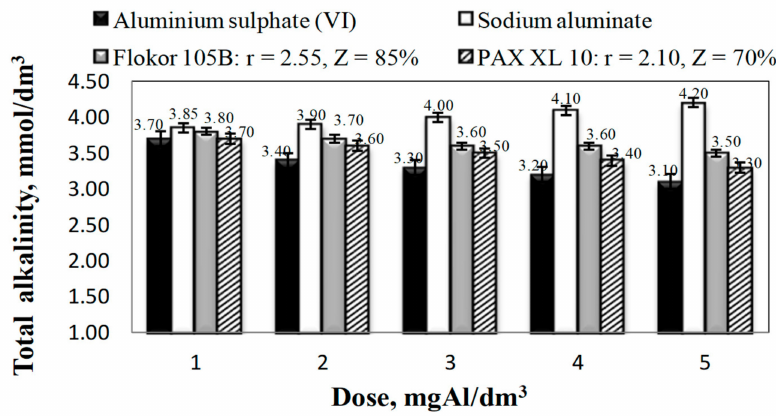
Figure 1. E ff ect of the type and dose of coagulants on alkalinity in purified